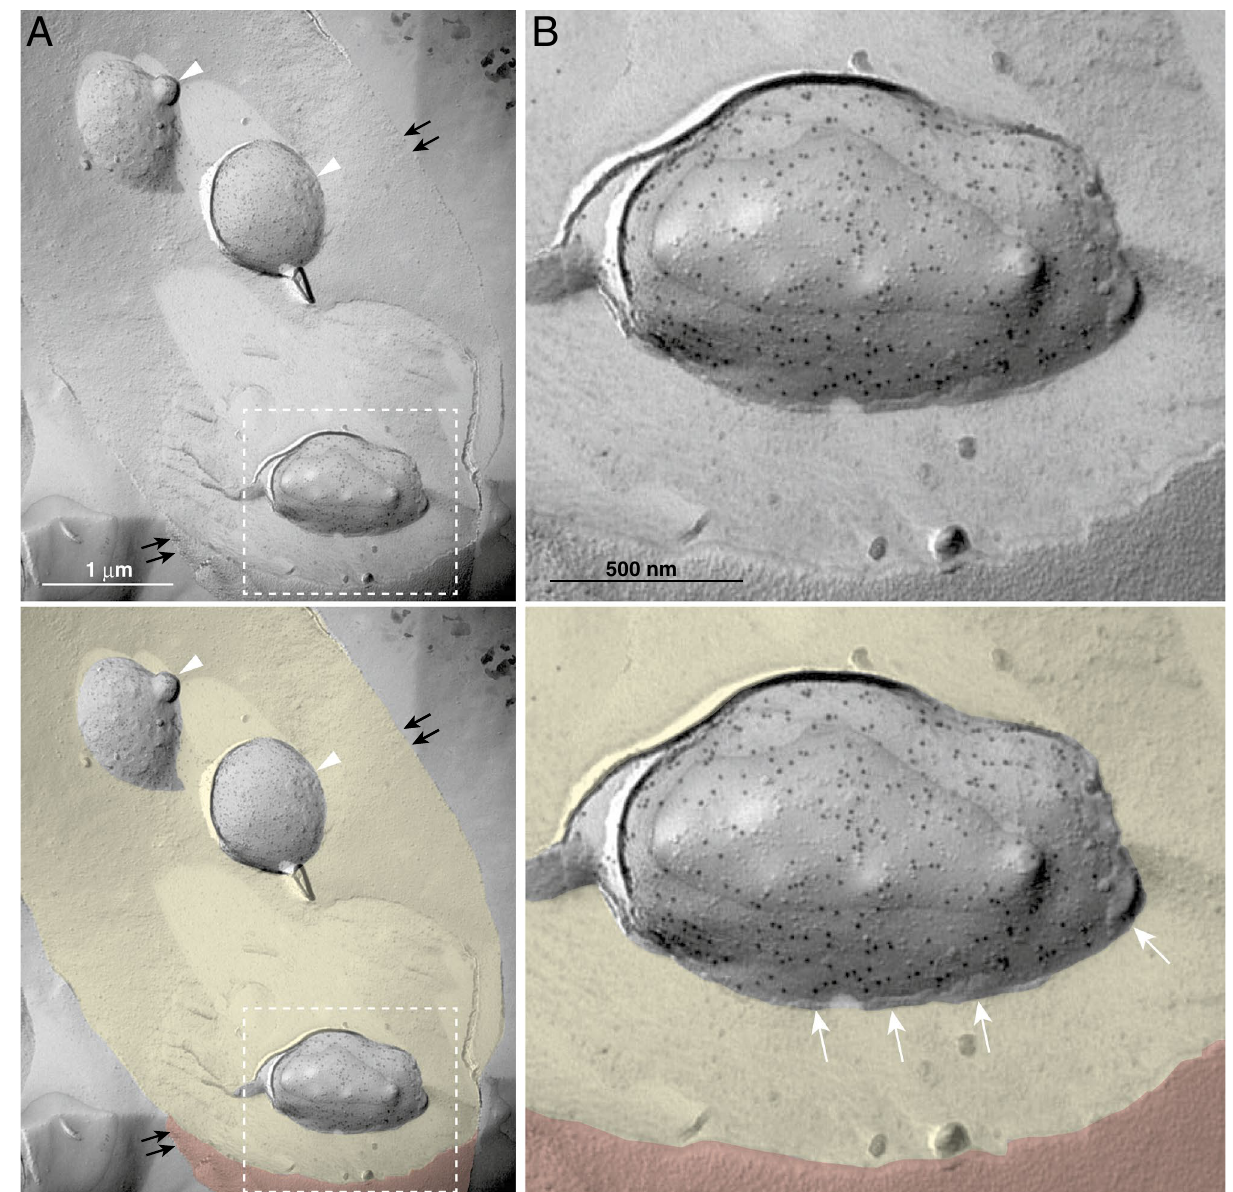
Figure 1. Observation of P. falciparum in a human erythrocyte. Using our freeze-fracture EM method, infected P. falciparum parasites were clearly observed inside human erythrocytes (white arrowheads). Double arrows indicate the erythrocyte plasma membrane. The labeling of anti-GM3 antibody was seen on the P. falciparum plasma membrane (A, B). The rectangle in A is magnified in panel B. In the lower panels of A and B, the plasma membrane and the cytoplasm region of P. falciparum -infected erythrocytes are colored with orange and yellow, respectively. White arrows indicate the luminal leaflet of the parasitophorous vacuole membrane. Scale bars: 1 μm ( A ) and 500 nm ( B